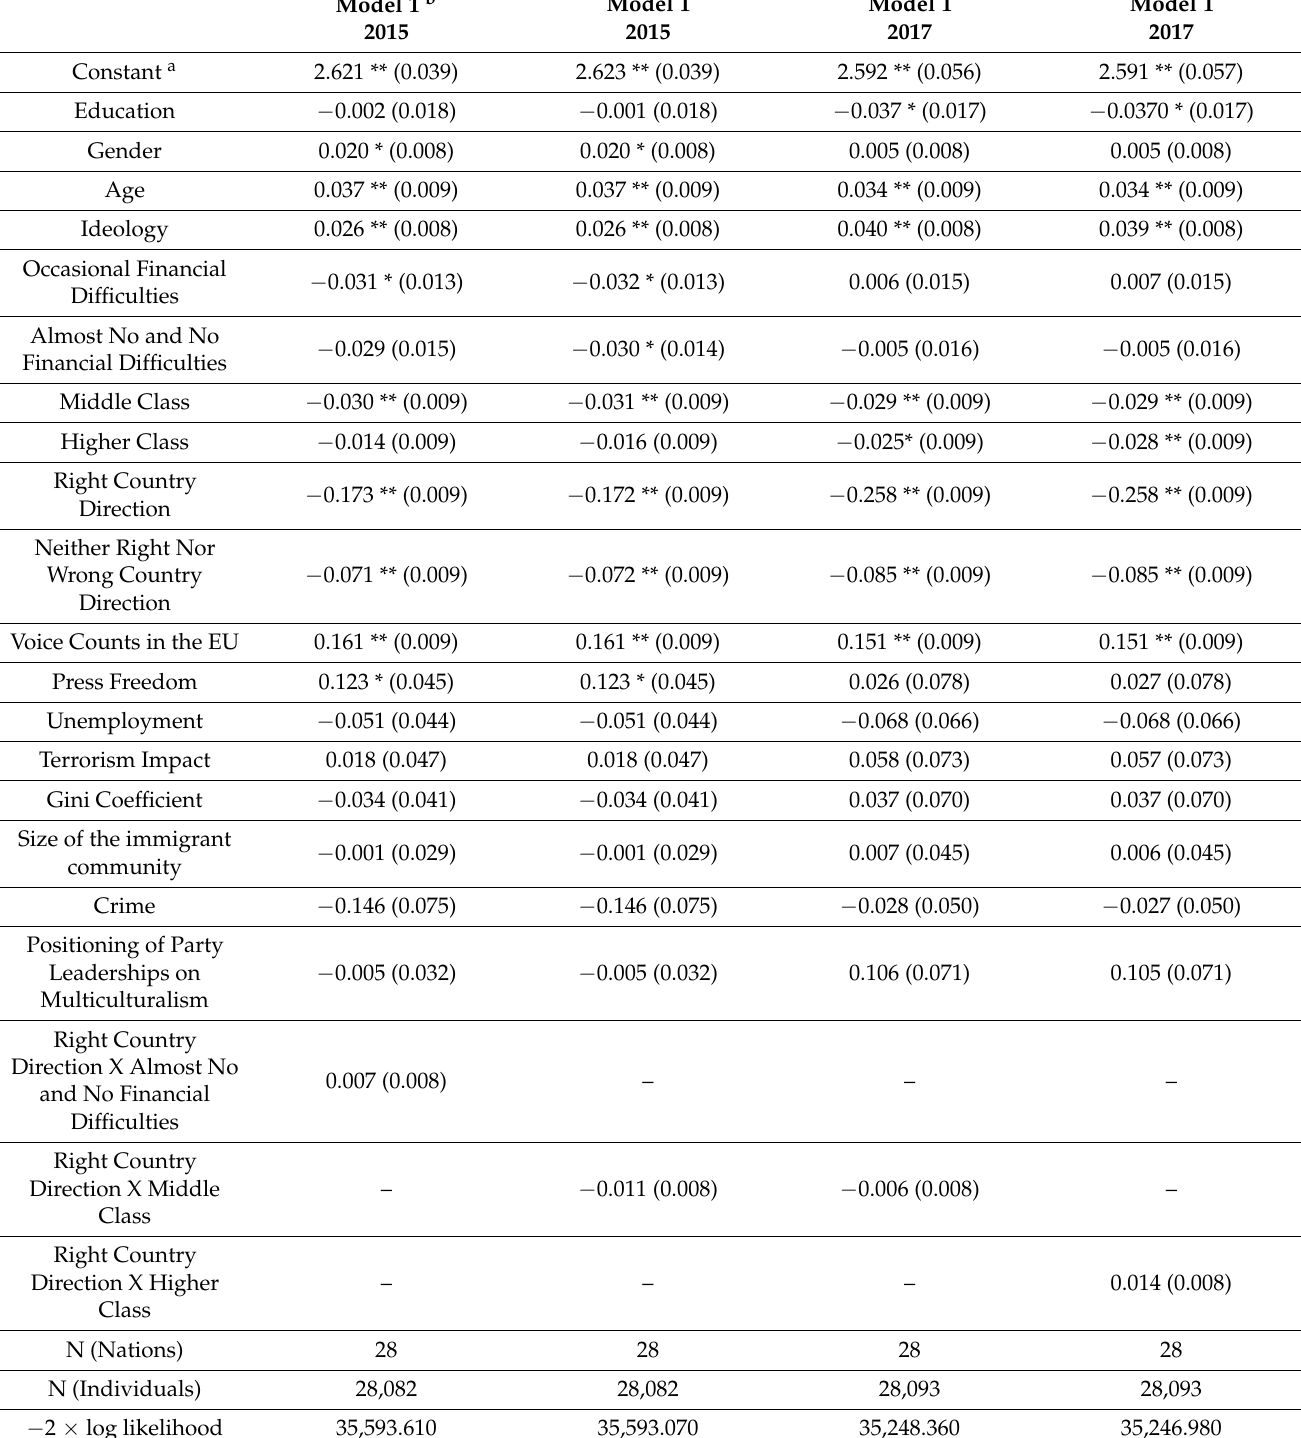
Table 5. Regression Estimates of Public Attitudes towards Terrorism